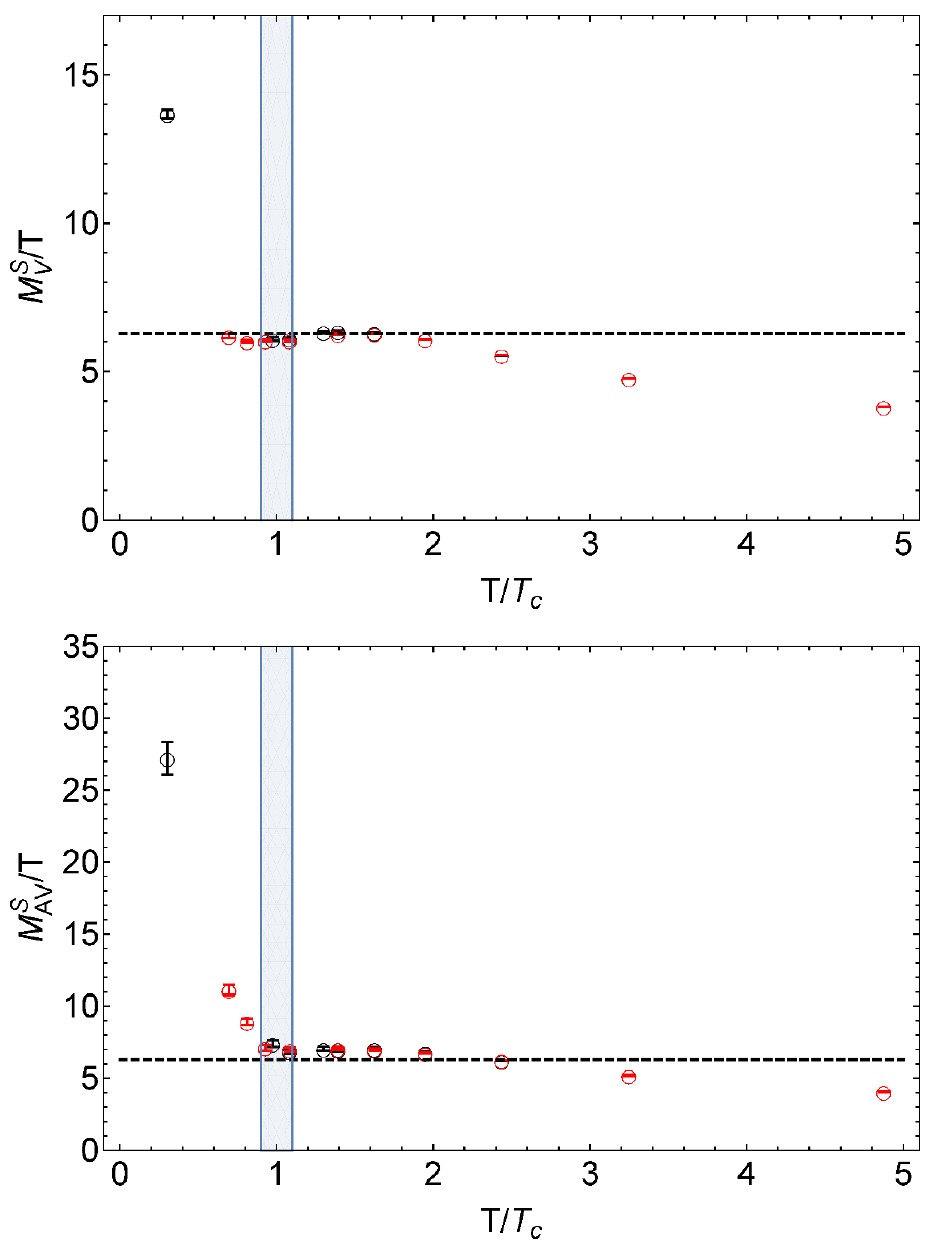
Figure 10 . Screening masses normalized by temperature for vector (top) and axial vector (bottom) mesons. Black and red points are extracted from ensembles of N t (cid:2) 16 3 and N t (cid:2) 16 2 (cid:2) 24, respectively. The temperature is in units of T c , where the blue vertical band denotes the uncertainty of T c itself.